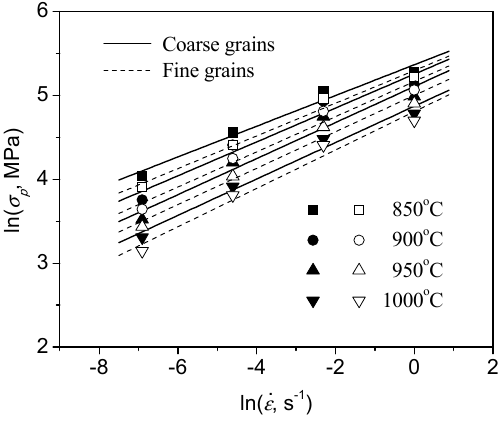
Figure 4. Relationship between the peak-stress and strain rate for the TB8 titanium alloys with two different initial grain sizes.